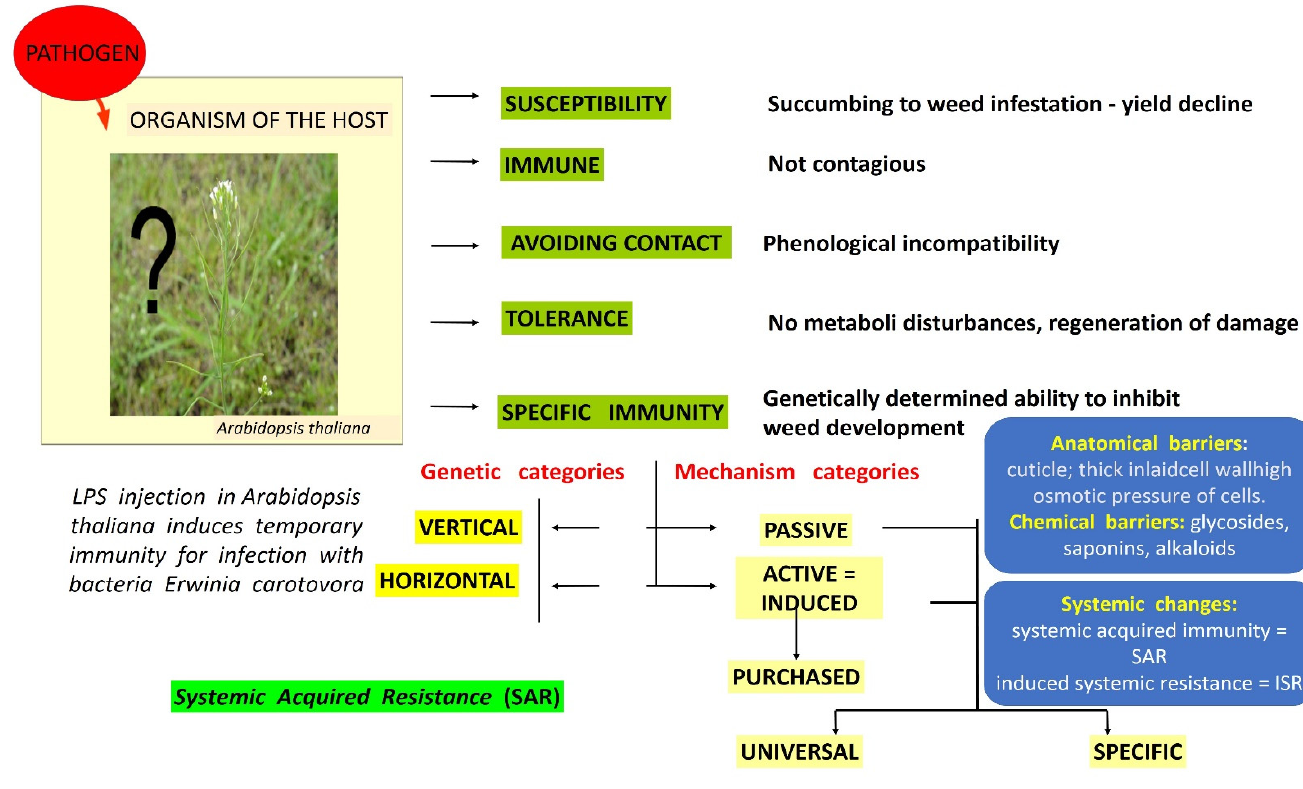
Figure 1. Plant resistance to biotic and abiotic factors. Source: own. Induced immune responses are triggered in response to a direct, sudden attack by a pathogen, injury or contact with a trigger molecule, or elicitor. They are a signal for the mobilization of the defense system in the whole plant, and the appearance of so-called systemic resistance. There is systemic induced resistance (ISR—induced system resistance) that is triggered by contact with non-pathogenic organisms or synthetic elicitors, and systemic acquired resistance (SAR—system acquired resistance), as a result of prior contact with the pathogen. However, as a result of the emergence of new data, this division is being systematically modified. Higher plants do not have specialized, mobile immune